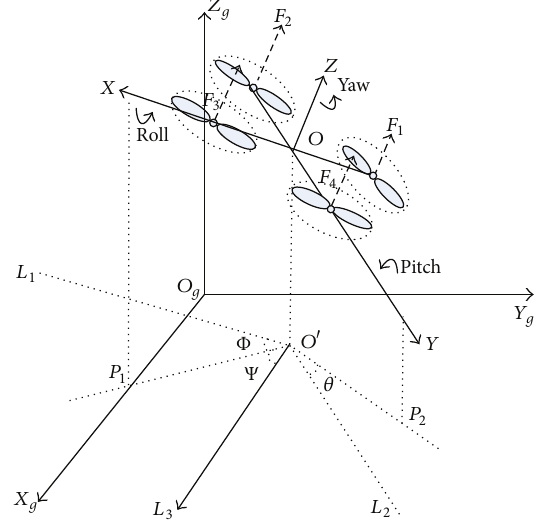
Figure 1: Transformation relationship between quad-rotor heli- copter and ground coordinate.